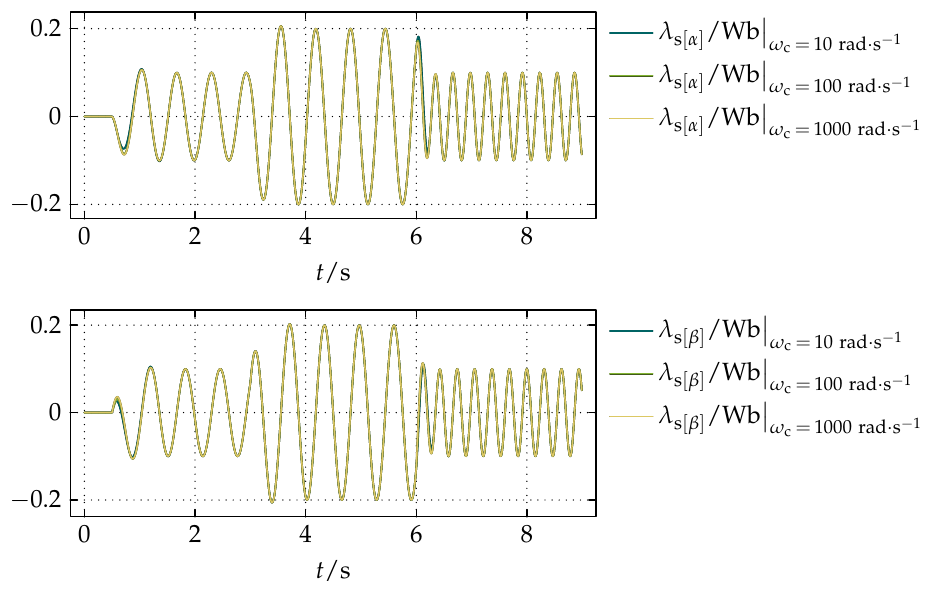
Figure 8. The resulting waveforms of λ s [ α ] and λ s [ β ] obtained by a simulation for k = 1 and different values of ω c